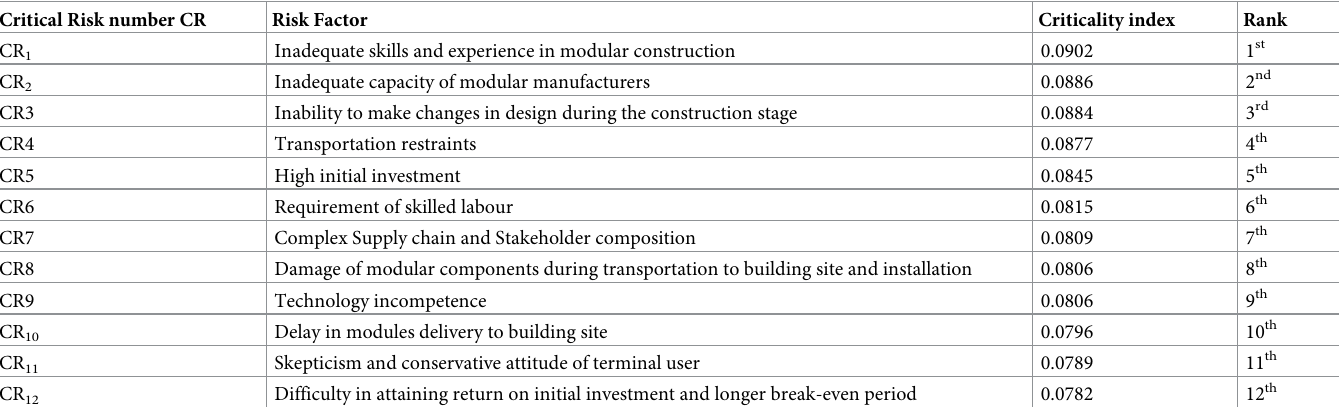
Table 7. Final ranking of critical risks based on criticality